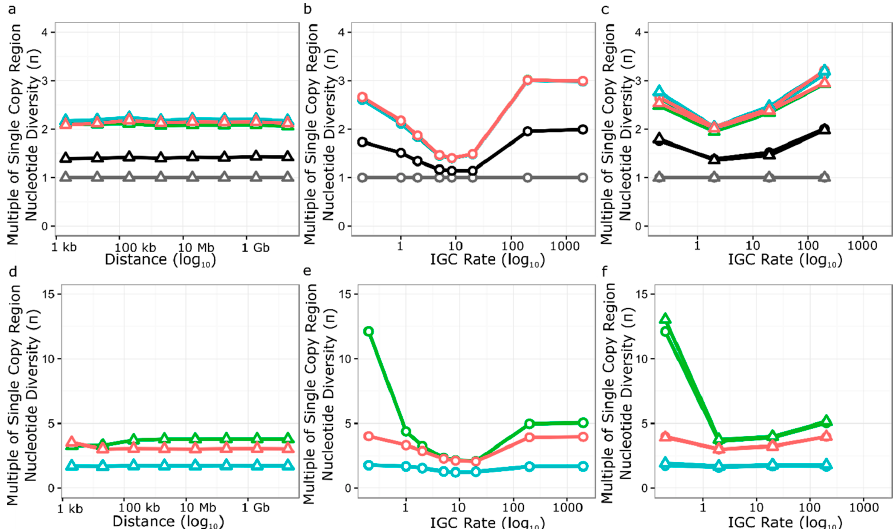
Figure 4. Simulation results for two and three copy gene families undergoing intergenic gene conversion with varying distance between copy two and copy three and varying IGC rates. Each point represents the average equilibrium nucleotide diversity from 200 independent extended SeDuS simulations. Nucleotide diversities relative to a single copy locus for one copy (grey), two copy (black), and three copy (green, blue, and orange are copies one, two, and three, respectively) systems are shown. Open circles represent simulations with equal exchange between copies, while open triangles represent simulations with unequal exchange between the three copies. ( a – c ) Neutrality. ( d – f ) Balancing selection maintaining copy two at 50% frequency within the population. ( a , d ) Varying the distance between copy two and copy three. ( b , e ) Varying the total IGC rate. ( c , f ) Varying the total IGC rate and the type of IGC tract exchange. Genes 2019 , 10 , x FOR PEER REVIEW